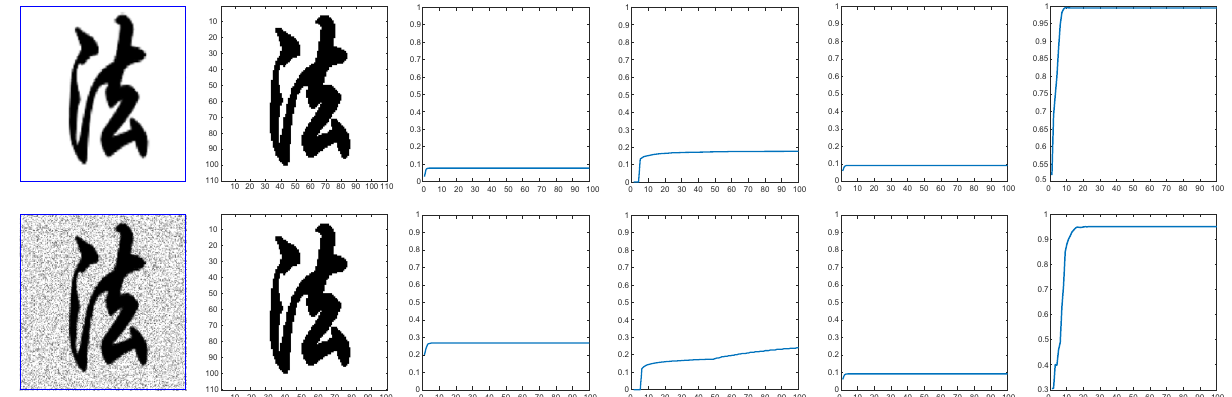
Figure 12. First row image is a clear image, second row denotes a nosy image. The second column shows the clean image. The Jaccard similarity coefficient for Wu et al. 24 , Li et al. 15 , Krinidis et al. 31 and the proposed model with p = 0.5 , µ = 0.7, and σ = 3 is shown in the third, forth, fifth, and sixth column. The x-axis denotes the iterations and y-axis is the Jaccard accuracy in each time step iteration.